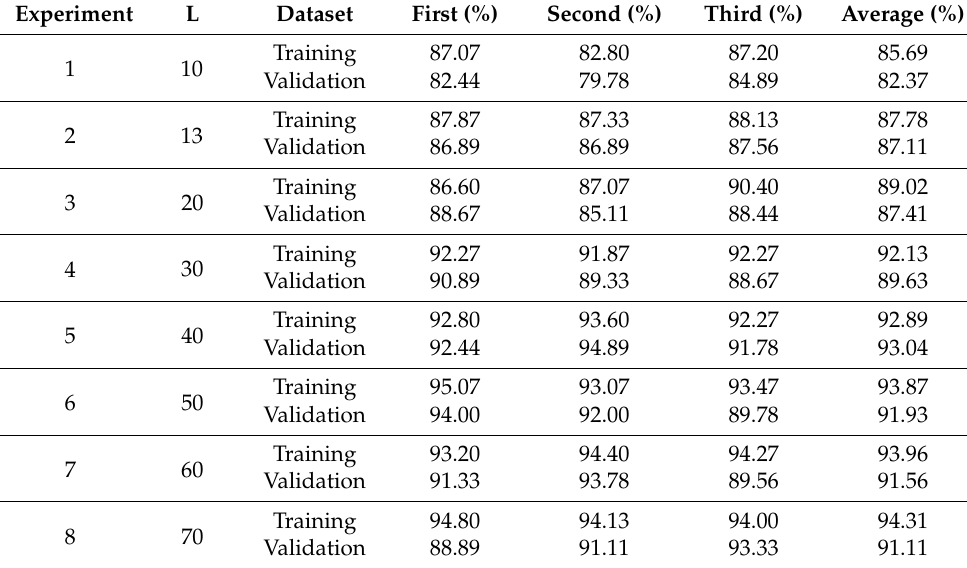
Table 3. Results of ELM model with different values of